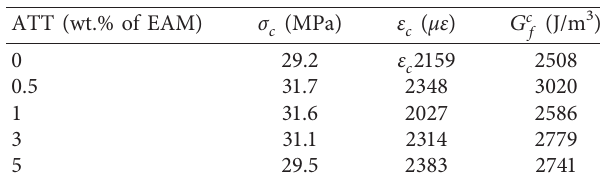
Table 7: Three-point bending results of EAM and EAM with ATT [122].